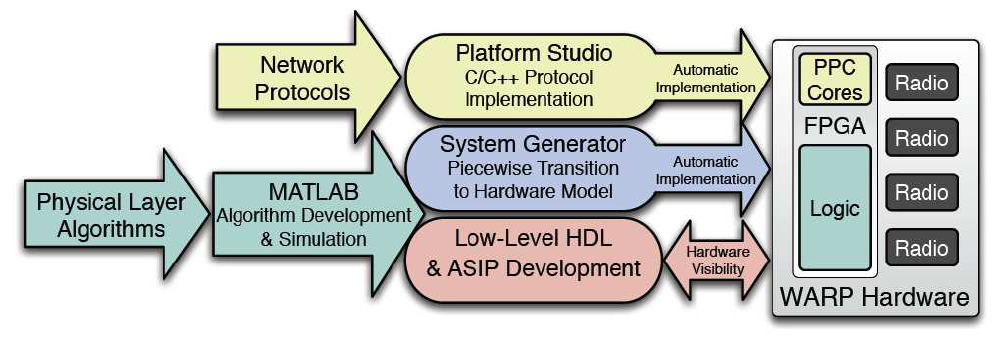
Figure 18. WARP design